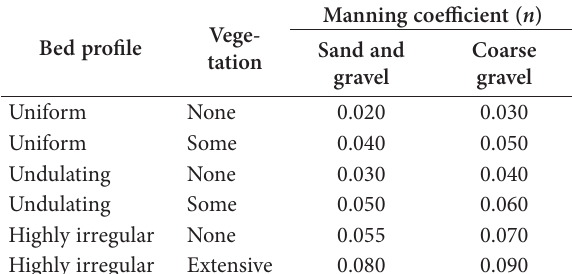
Table 2. Variation with bed profile, vegetation and